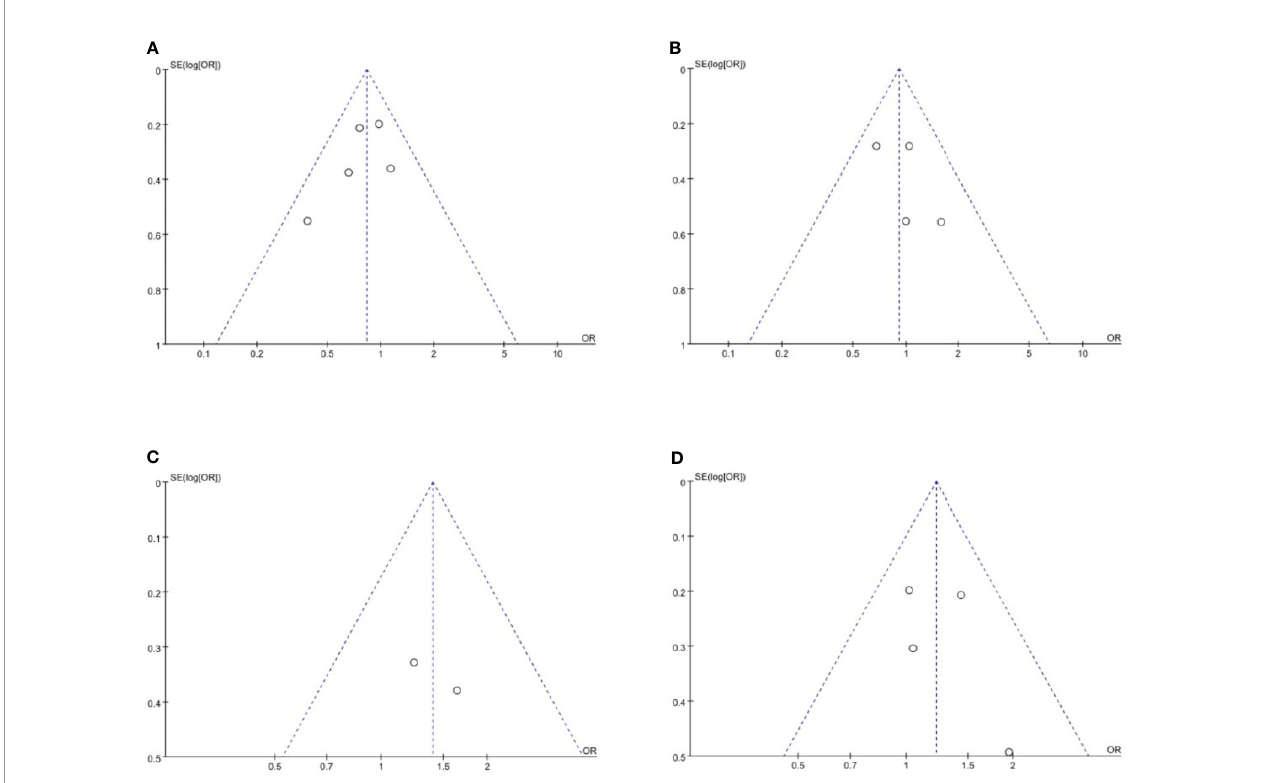
FIGURE 6 | Funnel plots of publication bias based on (A) overall recurrence rate, (B) peritoneal recurrence rate, (C) 3-year RFS rate and (D) 5-year RFS rate. RFS, relapse-free